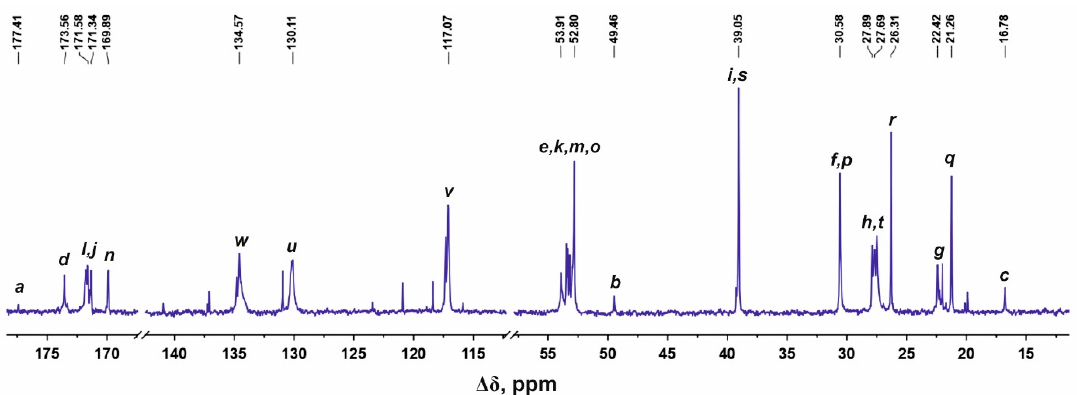
Figure 3. 13 C NMR spectrum of Lis-2His dendrimer in D 2 O at 25 °C. The letter symbols correspond to the designations of the groups in Figure 2.